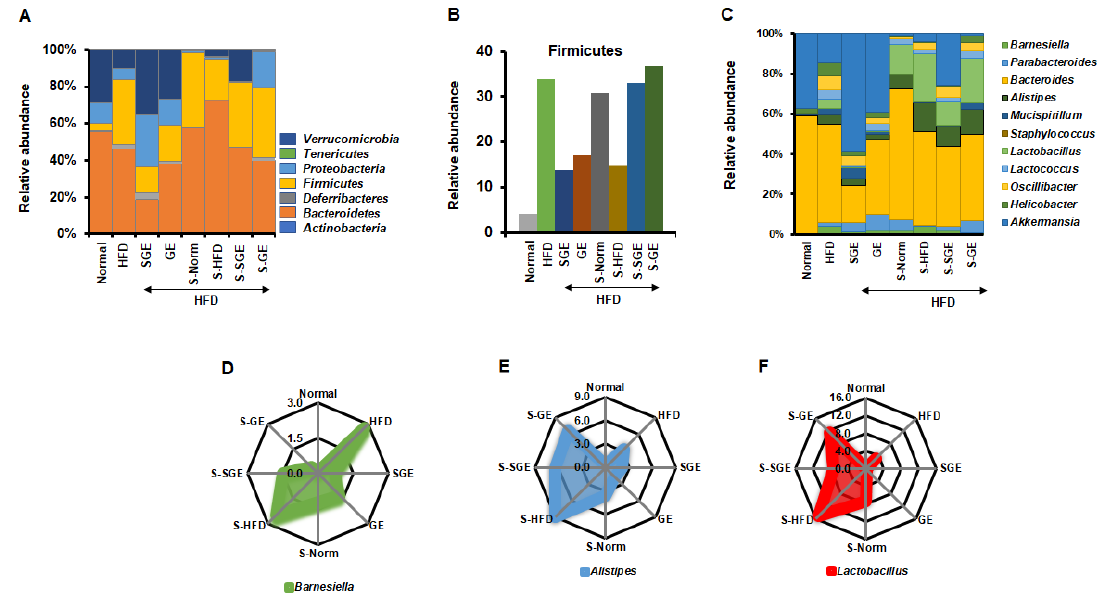
Figure 5. Korean red ginseng alters gut microbiota composition. ( A ) Relative abundance of gut microbiota at phylum level. ( B ) Relative abundance of Firmicutes. ( C ) Relative abundance of gut microbiota at genus level. ( D – F ) Relative abundance of Barnesiella ( D ), Alistipes ( E ) and Lactobacillus ( F ).